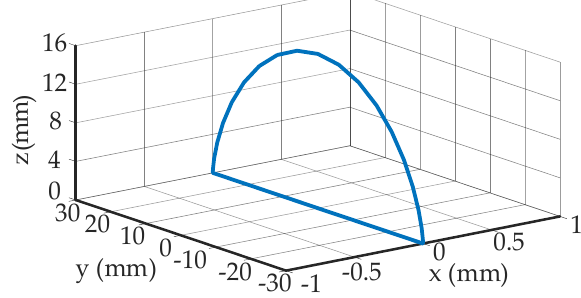
Figure 14. Foot trajectory curve of the hexapod.